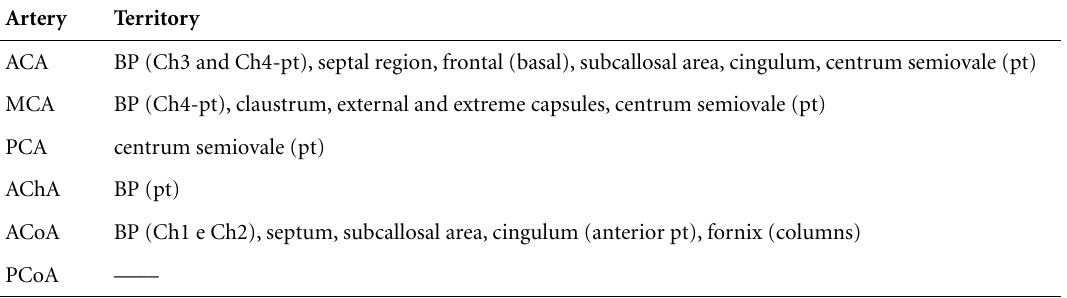
Table 2. Territories of the cerebral arteries related to cholinergic structures or their routes. Artery